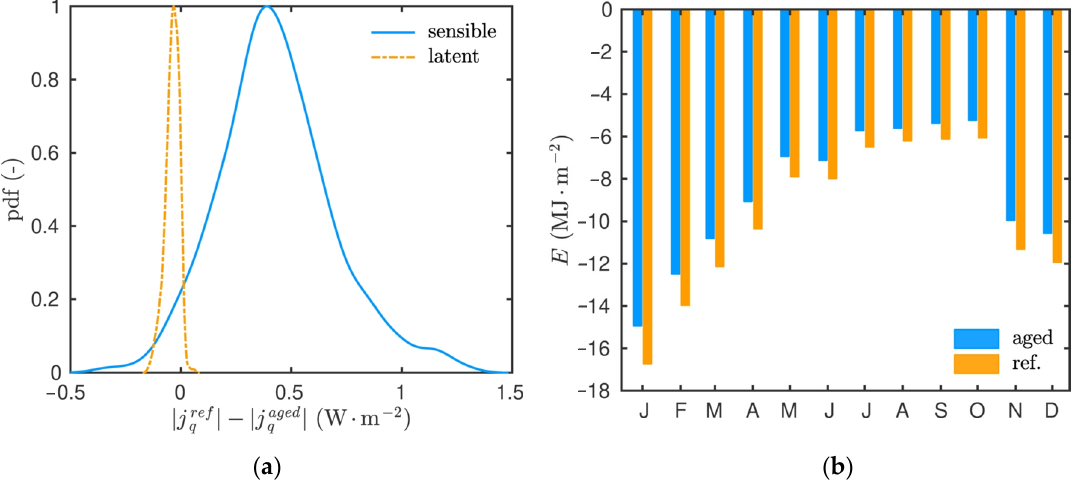
Figure 18. ( a ) Probability density function of the difference of heat flux between both configurations and ( b ) monthly conduction loads.